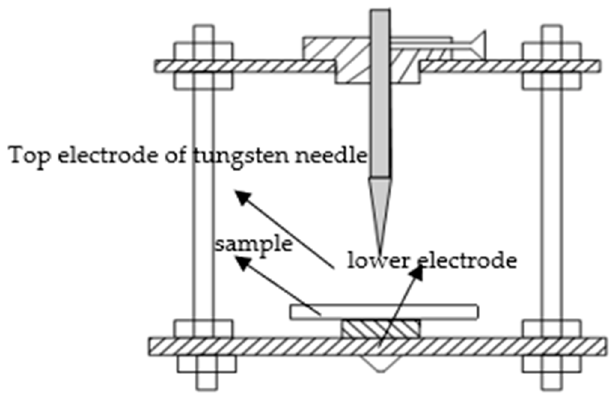
Figure 3. Electrode system for the corona breakdown test.